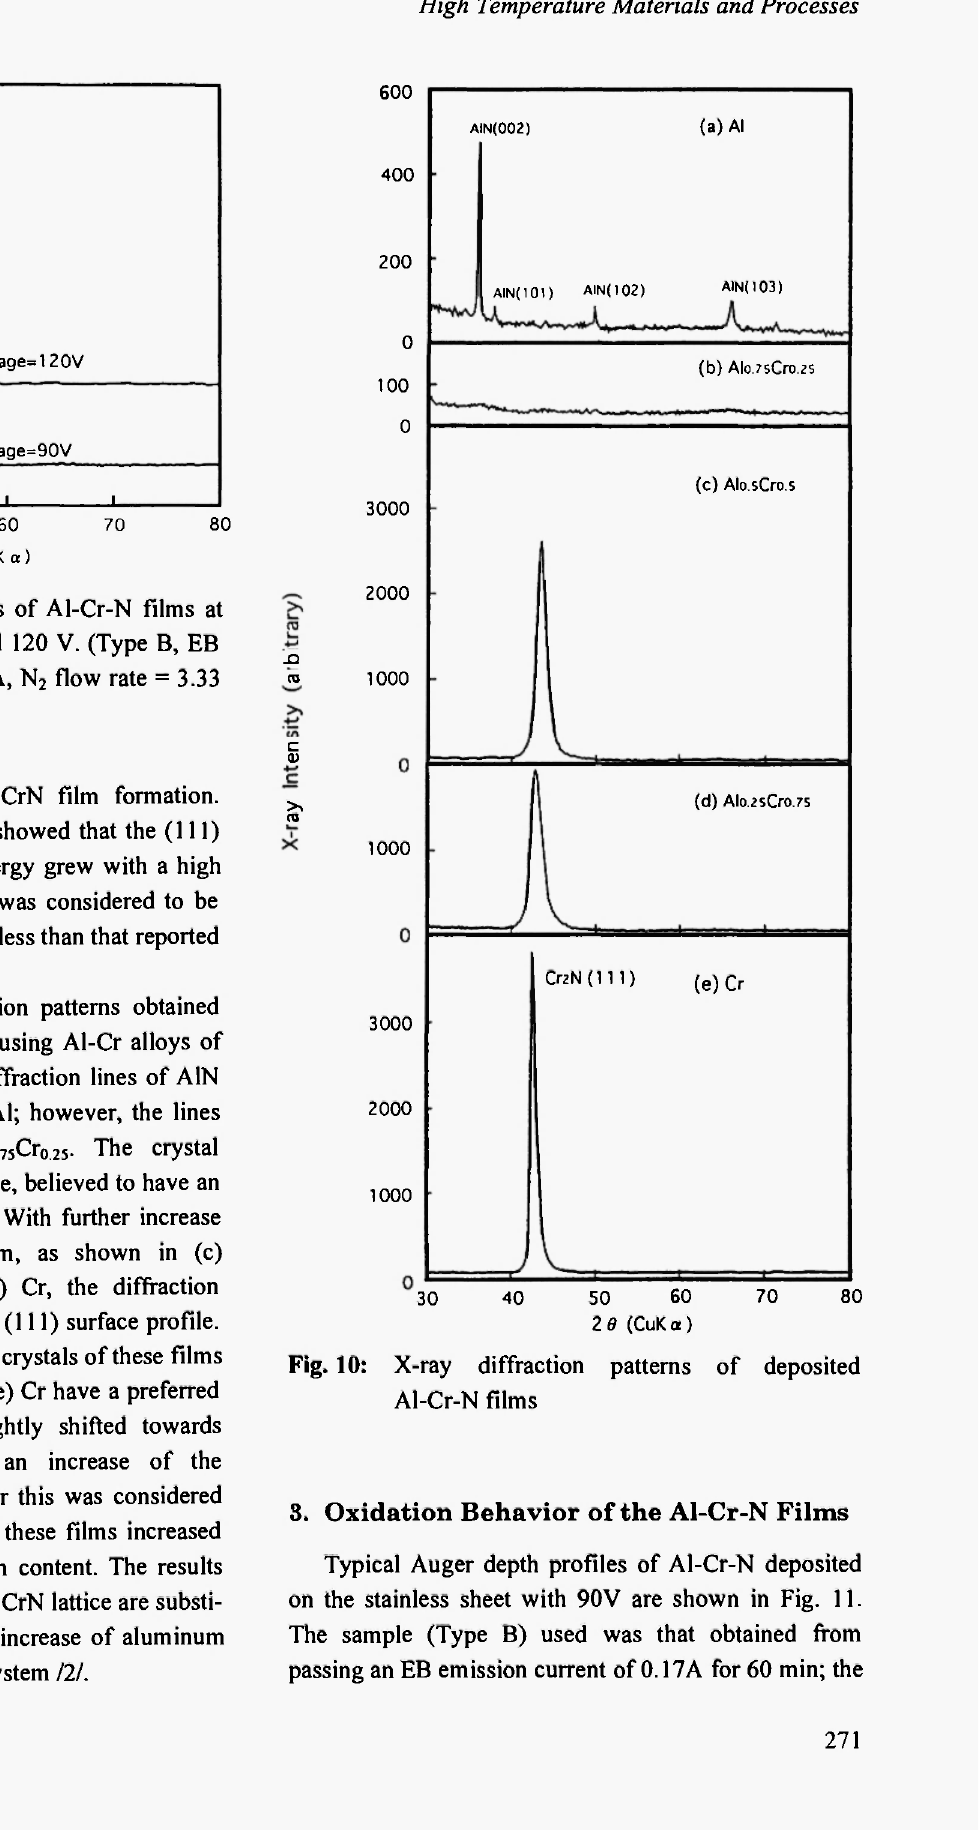
Fig. 10: X-ray diffraction patterns of deposited Al-Cr-N